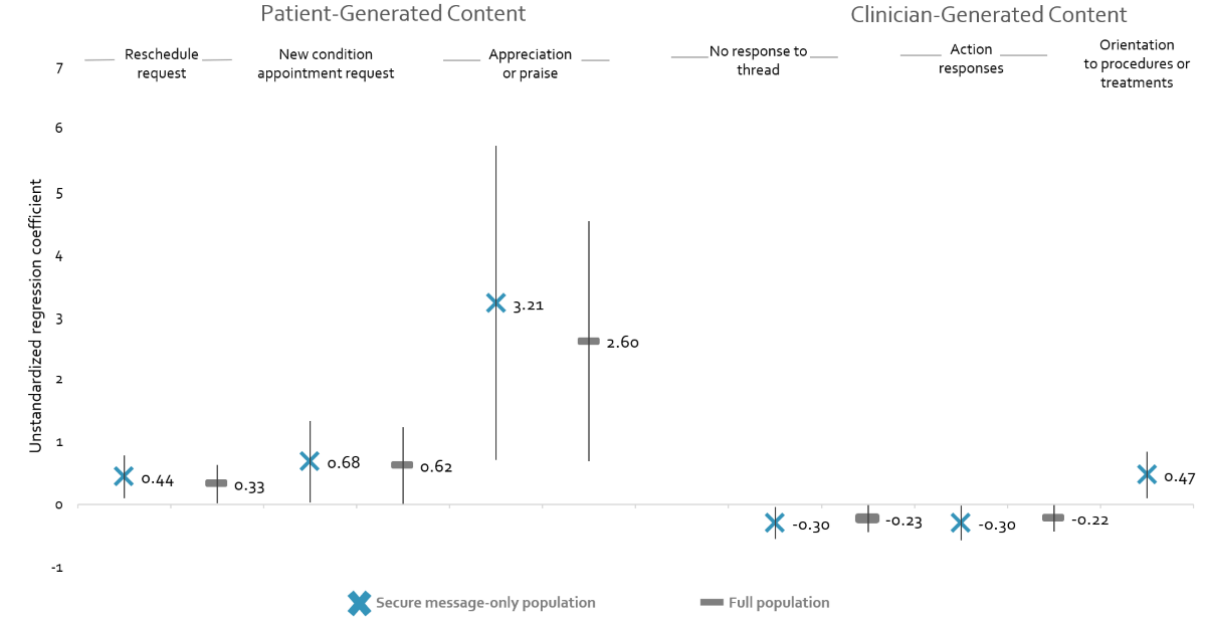
Figure 3. Associations between taxa and DBP changes. DBP: diastolic blood